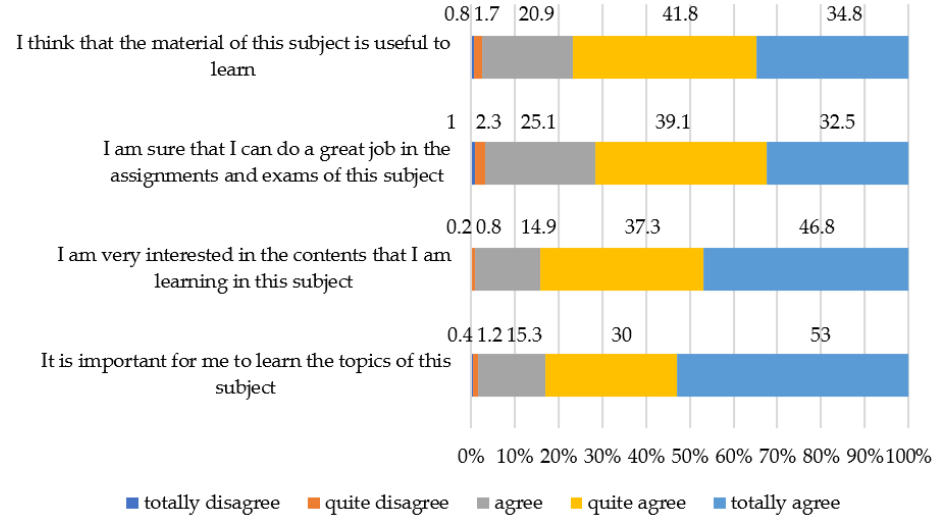
Figure 3. Level of ability to adapt to online teaching linked to the motivations construct.